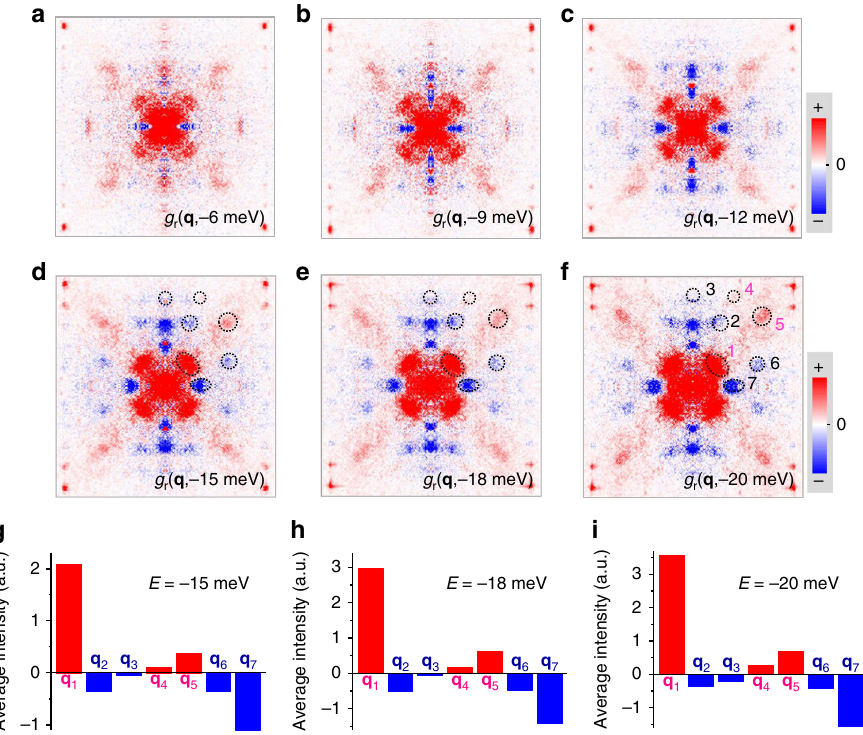
Fig. 5 PR-QPI signal by multi-DBS-QPI method. a – f PR-QPI images obtained directly from the FT-QPI patterns measured at different energies. Each digit in f denotes the position of each characteristic scattering wave-vectors. g – i Averaged intensity per pixel of PR-QPI signal for each q at − 15, − 18, and − 20 meV, respectively. The areas for the integral and average are marked by dashed circles or ellipses in d –